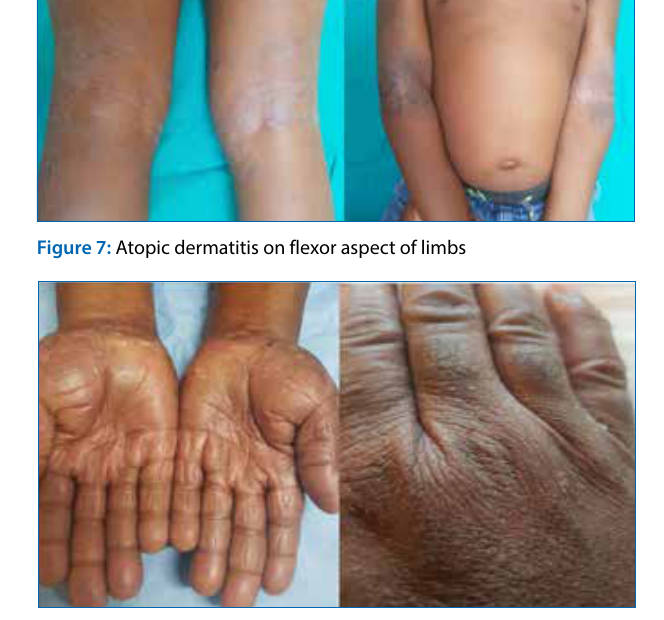
Figure 8: Hand dermatitis, palmar and dorsal aspects